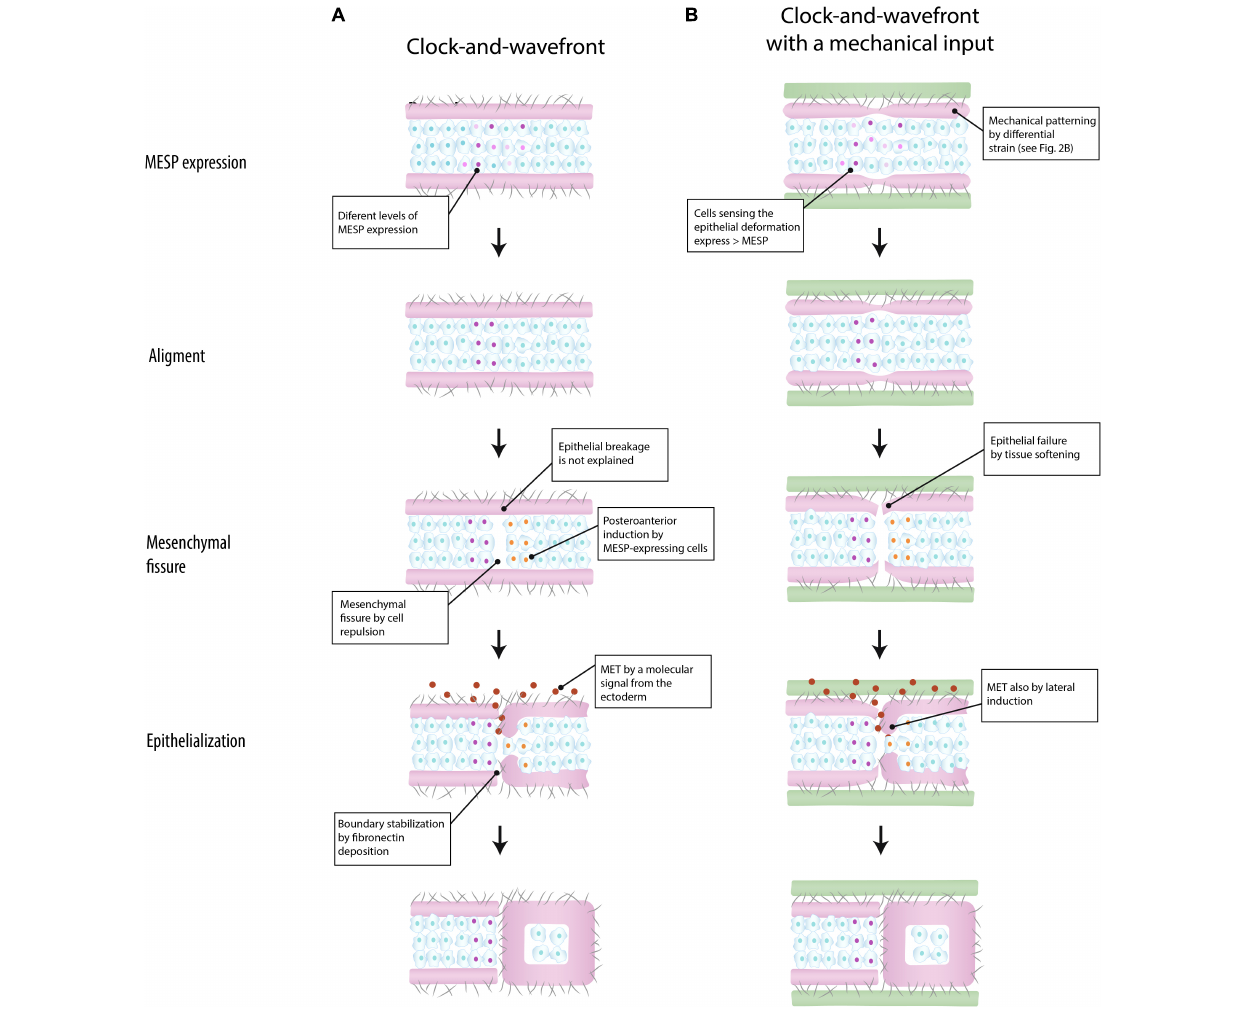
FIGURE 3 | Models of somite boundary specification in the paraxial mesoderm. According to Takahashi and Sato (2008), a somite boundary is marked by a clock-and-wavefront mechanism that triggers the expression of the segmentation program (MESP expression) in the mesenchyme. The epithelium plays a passive role (A) (based on Takahashi and Sato, 2008). In the integrated model suggested in the present work, the epithelium is mechanically patterned by differential strain, and conjointly with a clock-and-wavefront, it marks the location of somite boundary by aligning MESP expression (see the section “Discussion” for details) (B) (green: surrounding tissue; purple: epithelium; cells: mesenchyme; gray fibers: extracellular matrix; MET: mesenchymal-to-epithelial